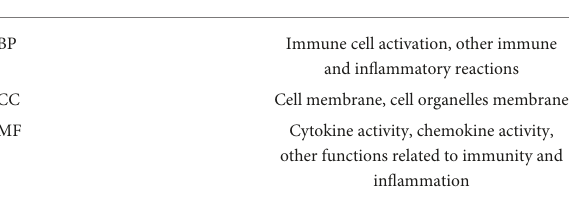
TABLE 2 Similar GO function analysis between Pmodel/sham and PEA/model.